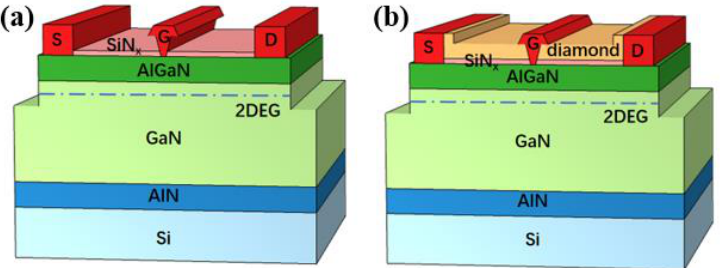
Figure 2. Capping diamond concept. AlGaN/GaN HEMT before ( a ) and after ( b ) growing the